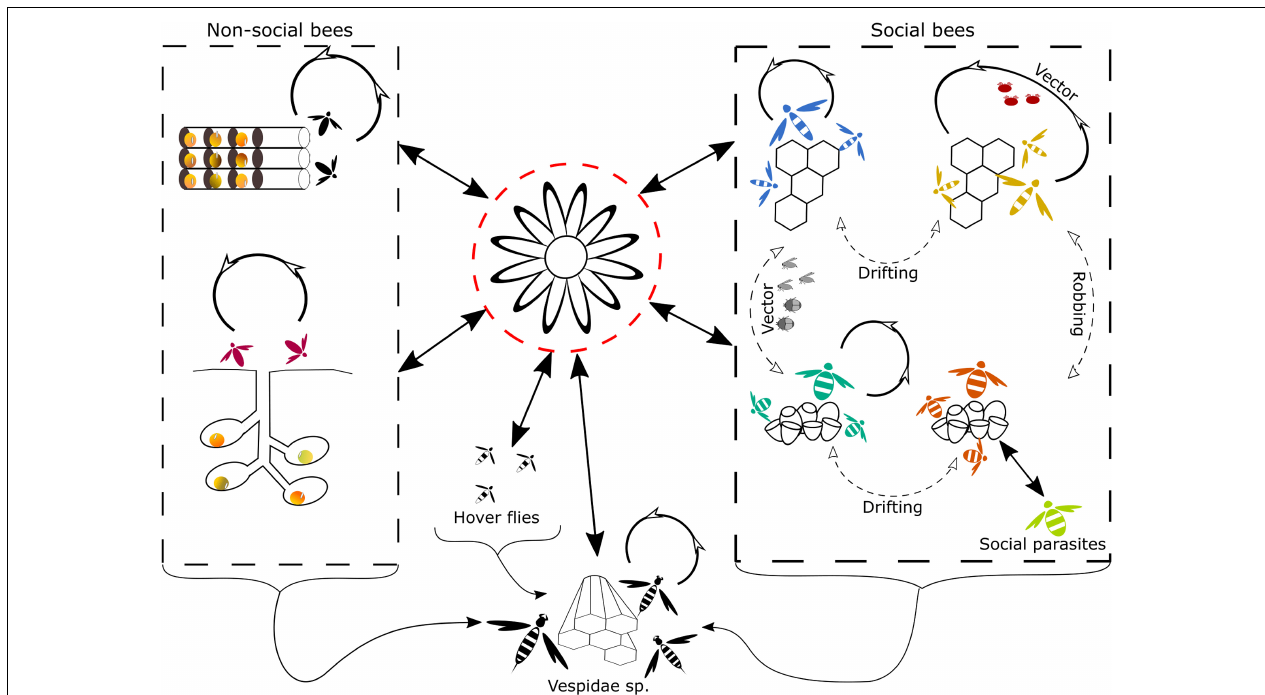
FIGURE 1 | Graphical representation of the natural routes of inter- and intra-species transmission of viruses found in Hymenoptera. Transmission routes that are more likely to occur are represented by solid arrows, transmission routes that are less likely or less frequently observed are represented by dotted arrows. The most likely route of inter-species transmission is through the use of shared flowers (Singh et al., 2010; Alger et al., 2019), depicted in the middle surrounded by a red dotted line. Inter- and intra-species transmission in non-social bees, depicted on the left side can occur through contact at nest aggregations or the reuse of virus-contaminated old nest cavities (Krunicì and Stanisavljevicì, 2006). In social bees, depicted on the right side, the main intra-species transmission route is likely, via intense contact in the nest. Social behavior such as trophallaxis and body contact could mediate transmission (Amiri et al., 2014, 2019; Chen et al., 2014; Coulon et al., 2018 and others, see main text). Further intra-species transmission can also occur via vectors, for honey bees this is a very important transmission route for several viruses, mediated by V. destructor (Santillán-Galicia et al., 2010; Möckel et al., 2011; Gisder et al., 2018; Posada-Florez et al., 2019; Ryabov et al., 2019 and others, see main text). Intra-and inter-species transmission via vectors, other than V. destructor [e.g., the small hive beetle, phorid flies (Eyer et al., 2009; Core et al., 2012; Menail et al., 2016)] are less frequent. Robbing and drifting are also two potential routes of inter- and intra-species transmission, respectively, described in social bees. Yet their role in virus transmission is likely to be minor compared to other transmission routes. Lastly, social parasitism creates a high contact between individuals from different species and hence is likely to facilitate virus transmission, in social bees. Inter-species transmission in Vespidae sp. can occur through feeding on infected Hymenoptera, or other insects that are infected with a virus or contain the virus on their exterior (Loope et al., 2019). Another potential transmission route for wasps is the use of shared contaminated flowers (Mordecai et al., 2016b). Intra-species transmission in social Vespidae sp. is also likely to occur via intense contact within the